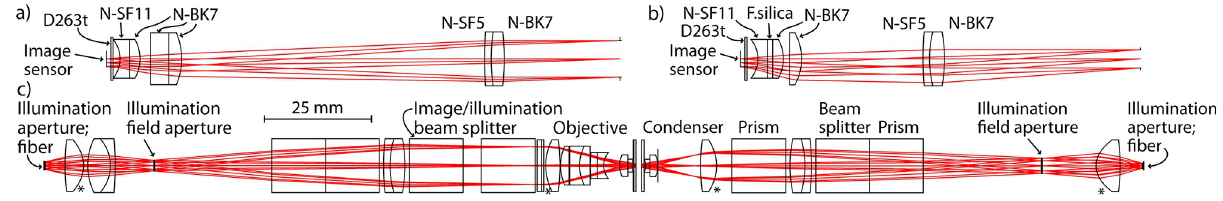
Fig 3. Top: 50mm (a) and 25mm (b) camera objectives. Bottom (c): Top (left) and bottom (right) bright field illumination channels. The dark field channels differ only by the absence of one prism and a different aperture. The asterisk indicates a hybrid-aspherical surface.